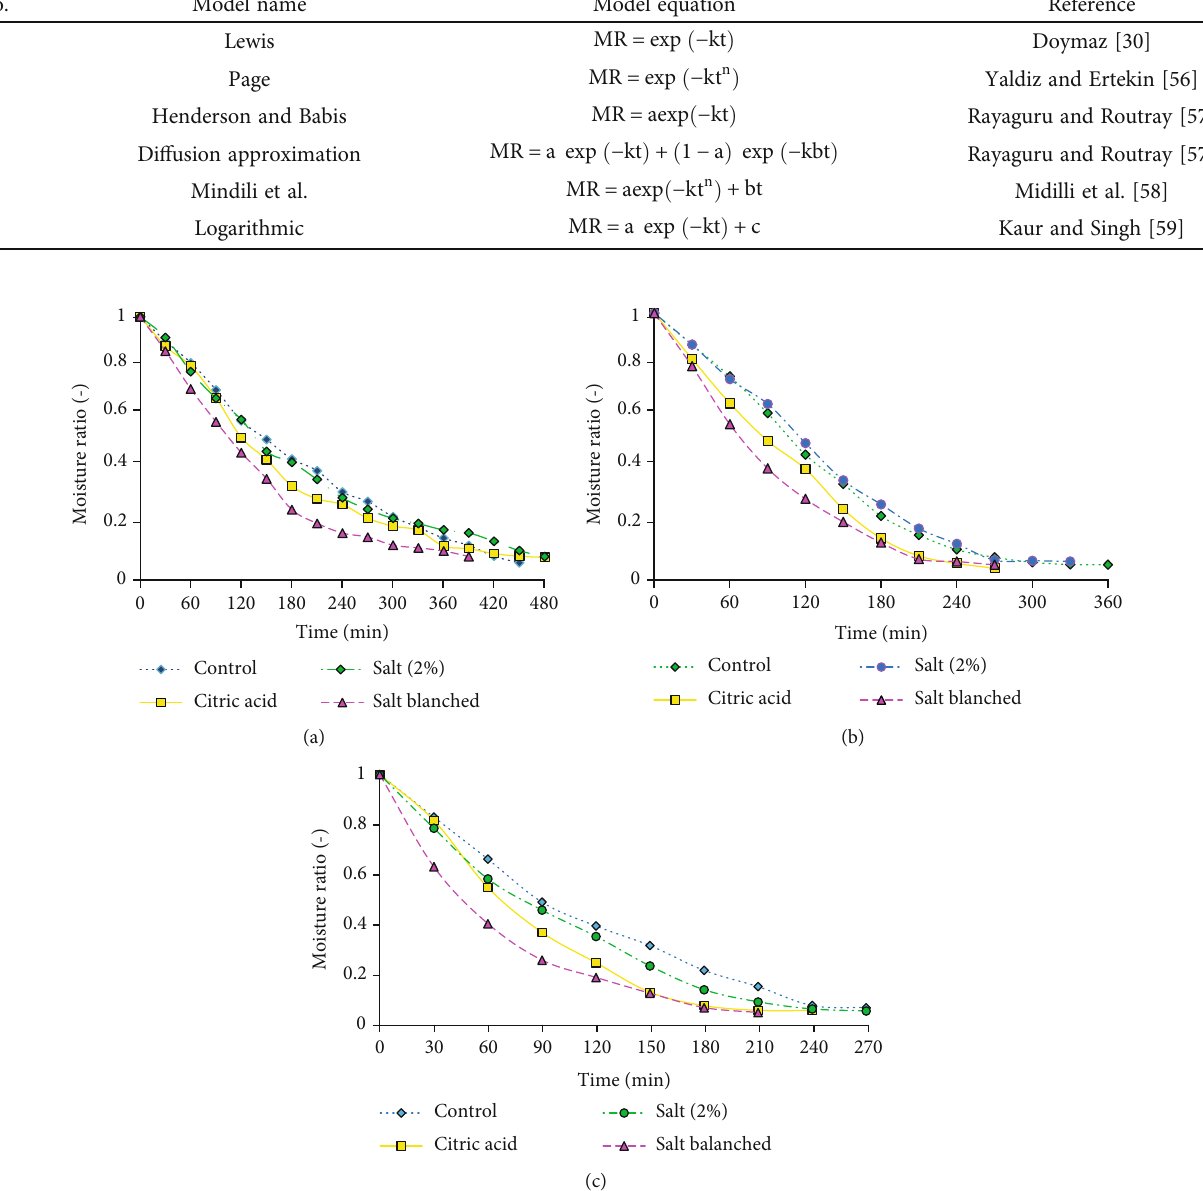
Figure 2: Moisture ratio of pumpkin slices versus time at di ff erent pretreatment conditions for zone I of the drier (a), zone II of the drier (b), and zone III of the drier (c). Pretreatments are 1% citric acid solution for 20 minutes, 2% salt solution for 20 minutes, and blanched in 1% salt solution at 65 ° C for 2